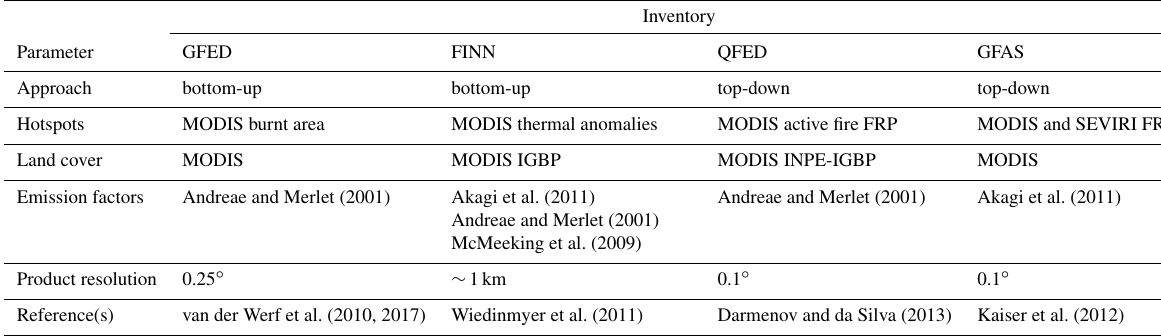
Table 4. Details of inventories used to compare VFEI